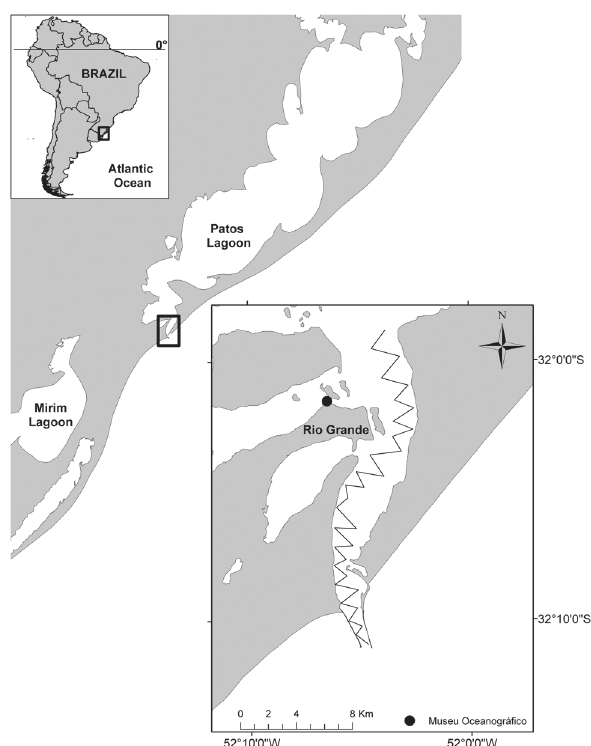
Figure 1. Survey route followed during survey trips conducted in the Patos Lagoon estuary, southern